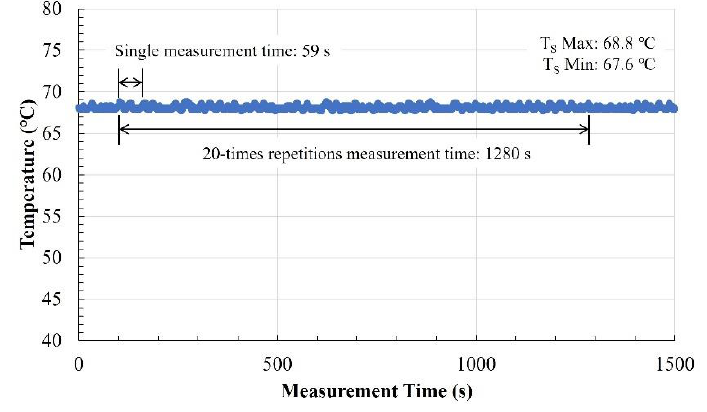
Figure 8. Heatsink temperature during measurement time.